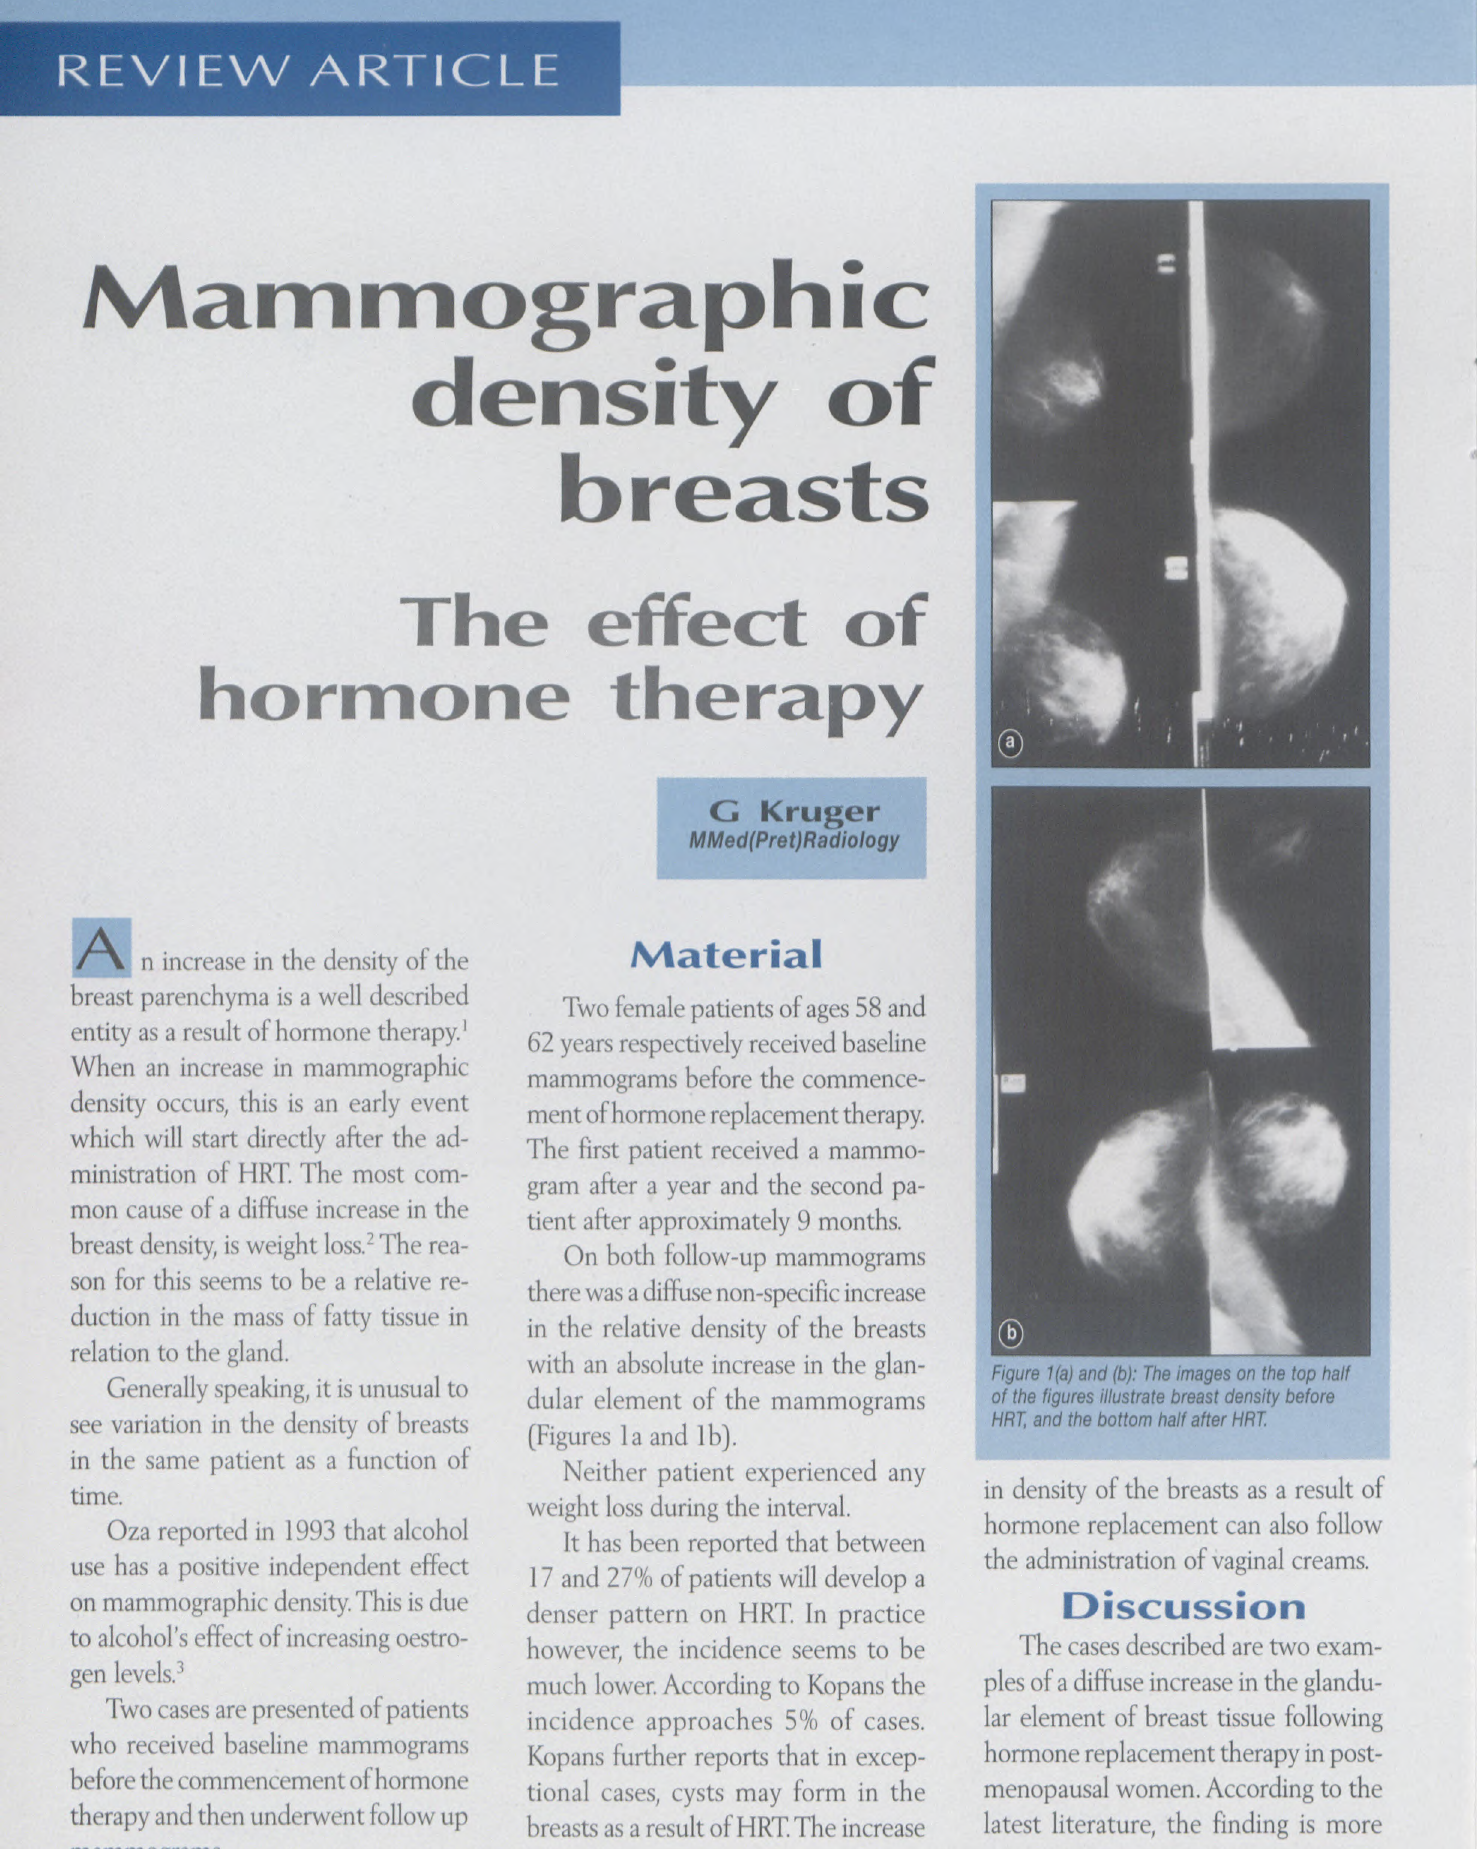
Figure 1 (a)and (b): The images on the top half of the figures illustrate breast density before HRT, and the bottom half after